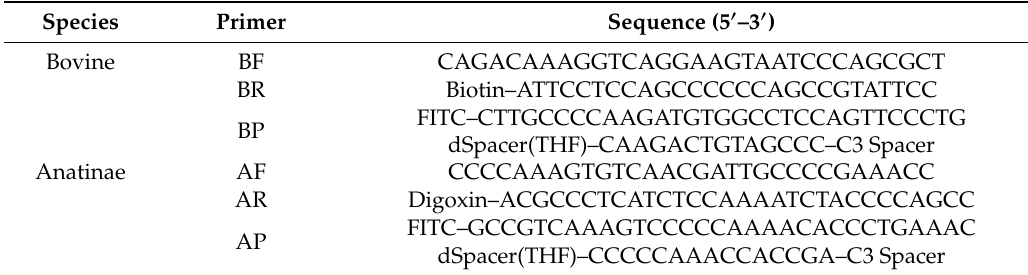
Table 1. The sequence information of primers and